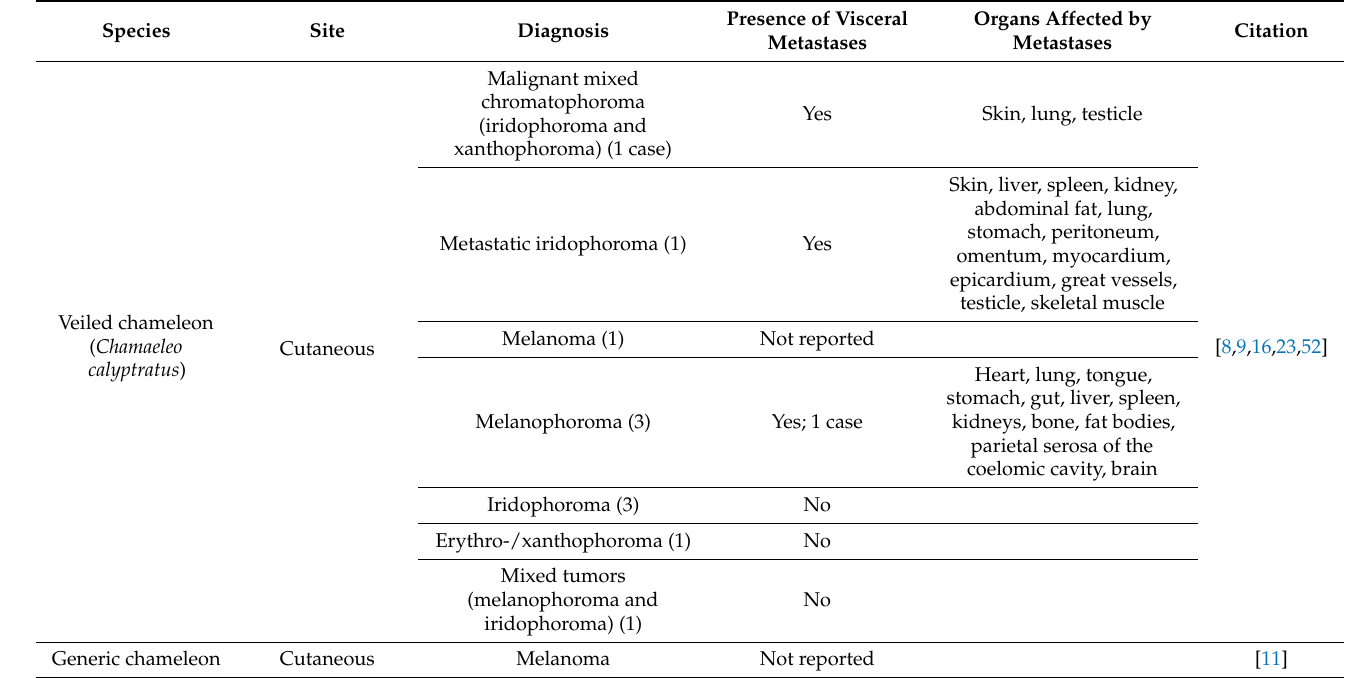
Presence of Visceral Organs Affected by Metastases